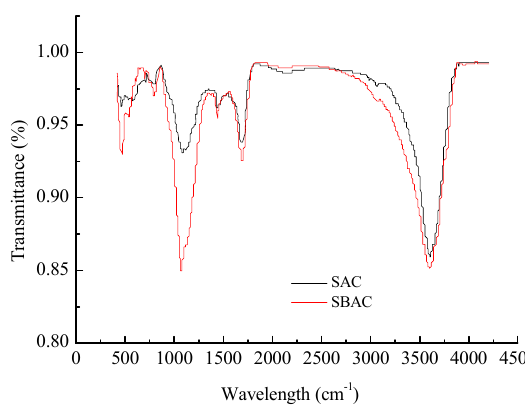
Figure 3. FTIR of SAC and SBAC samples.